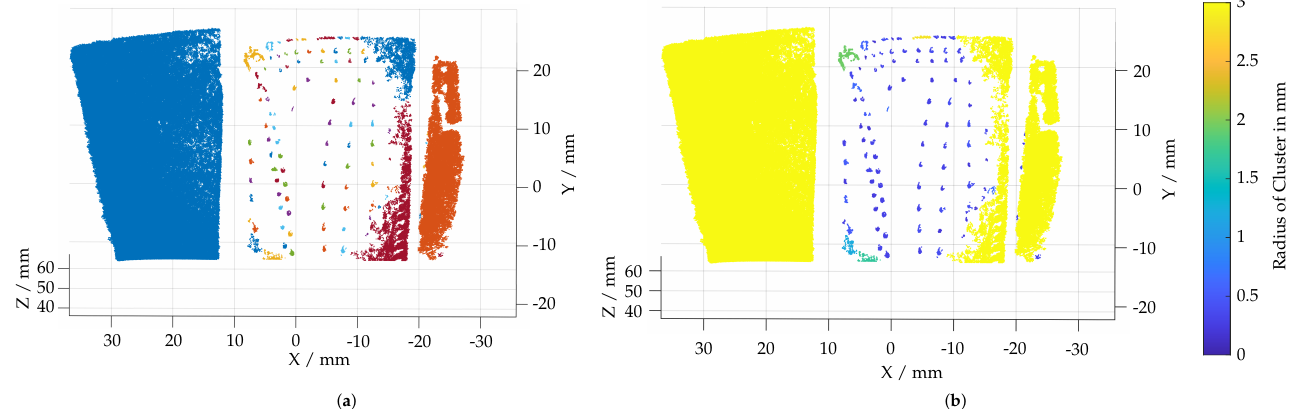
Figure 7. Visualization of the clustering approach used to separate film-cooling holes. ( a ) Clusters calculated using a DB Scan algorithm. ( b ) Radius of an evolving sphere fitted to each cluster.